Question: Describe this figure in one sentence.
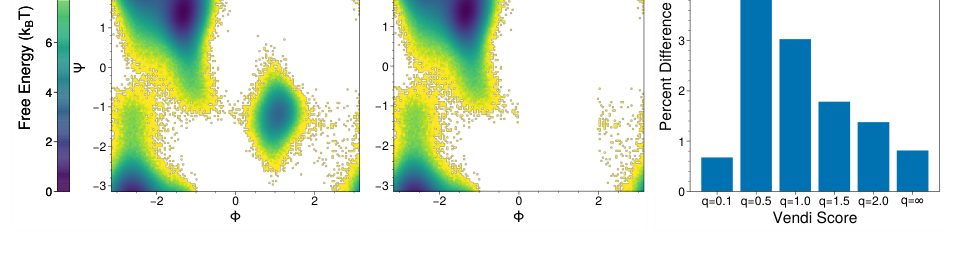
Answer: Sensitivity of different Vendi scores to missing Alanine Dipeptide conformation. Left: Ramachandran plot from an unbiased simulation of Alanine Dipeptide plotted against the two dihedral angles φ,ψ. Center: Ramachandran plot after removing the left-handed conformation. Right: The percent difference for different Vendi scores between samples from the original simulation and samples missing the left-handed state. Vendi scores are calculated using 20,000 molecules from each set of samples using an invariant RBF Kernel with γ = 1.